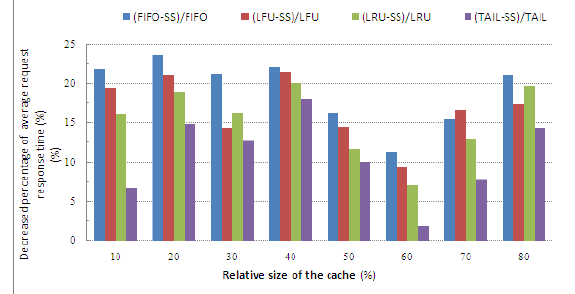
Figure2. Decreased percentage of the tile-request average request response